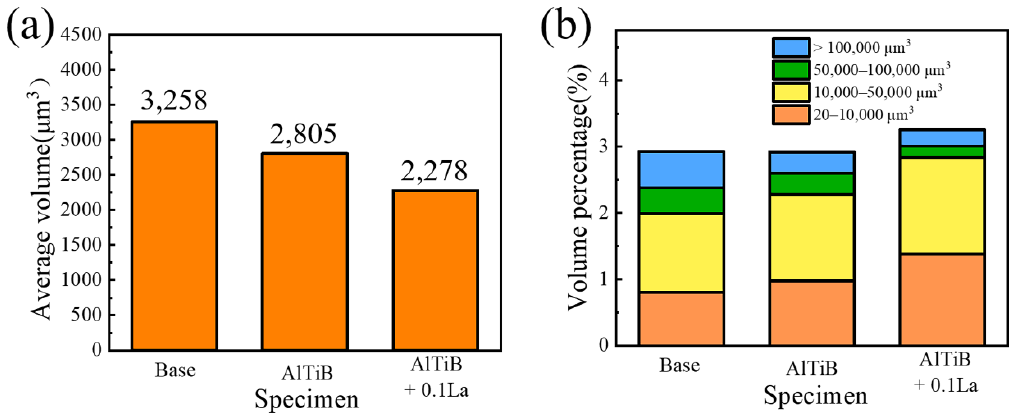
Figure 10. ( a ) Average volume of intermetallic compounds; ( b ) Percentage of intermetallic com- pounds of different sizes in the volume of the alloy.